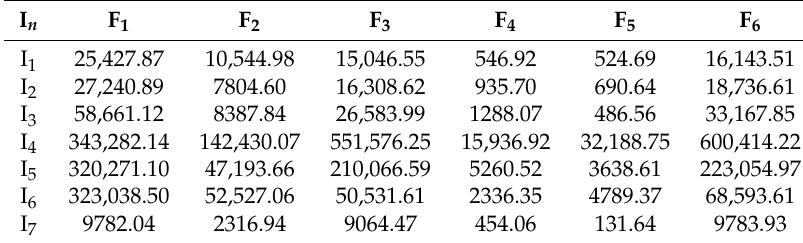
Table 4. Data in